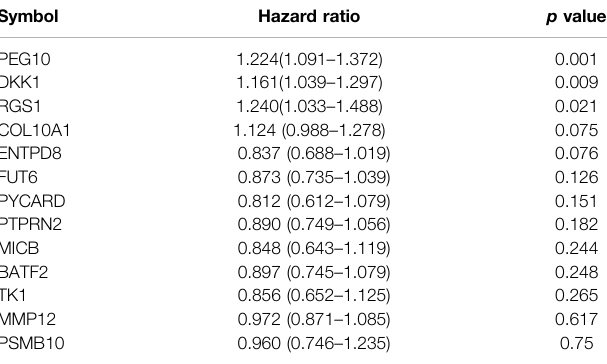
TABLE 2 | Results of univariate Cox regression analysis. Symbol